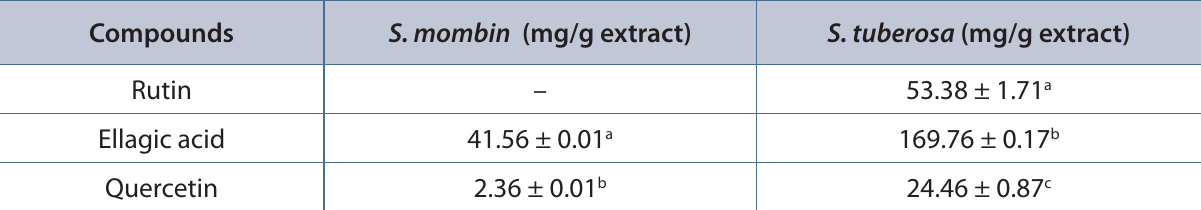
Different letters indicate statistically significant differences between rows in the same column, p <